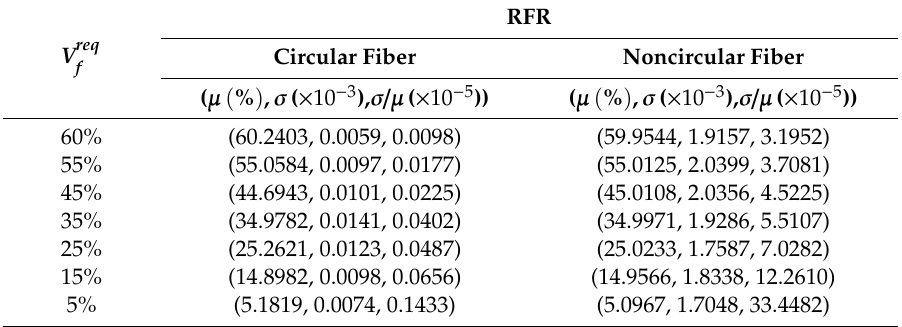
Table 2. Mean, SD, and RSD of f V of RVE samples corresponding to req f V .